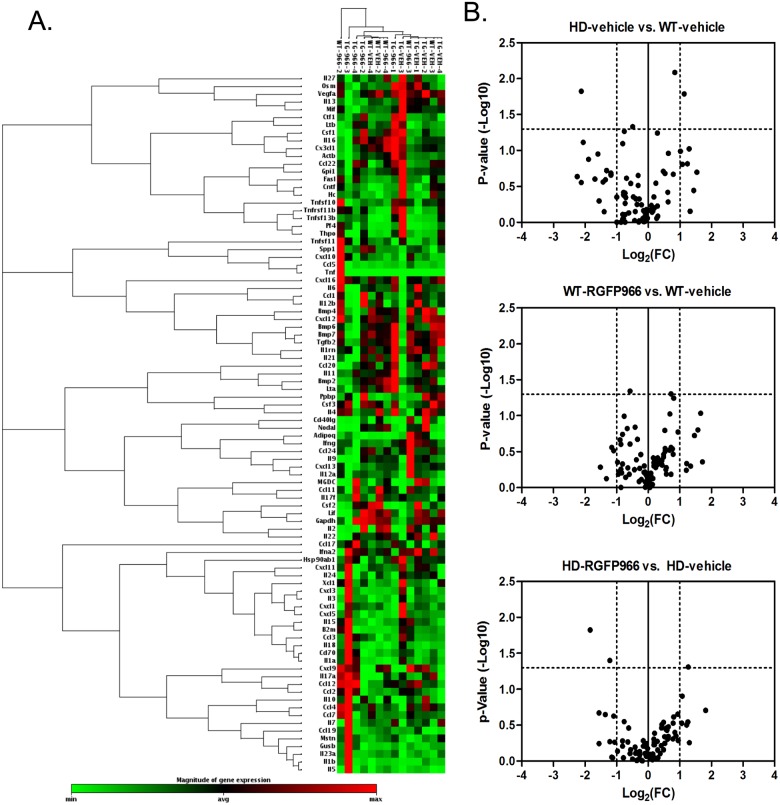
Summary of cytokines array gene expression changes in striatum due to RGFP966 treatment.A. Heatmap of expression values for 84 cytokine/chemokine genes showing two-way clustering of expression levels and treatment groups. Red denotes increased relative gene expression levels for the indicated groups, with green denoting decreased expression levels. B. Volcano plots of expression changes due to RGFP966 treatment showing three different comparisons, as indicated. Dotted line on y-axis denotes the significance cut-off of p-value<0.05, using one-way ANOVA. Dotted lines on x-axis denote a fold-change cut-off of > +/- 2.